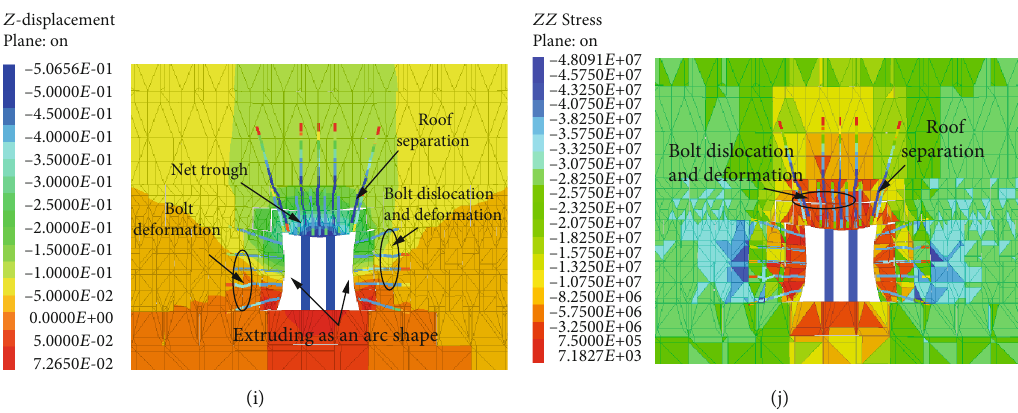
Figure 11: Numerical simulation results of surrounding rock deformation in the di ff erent schemes: (a) cloud graph of vertical displacement of scheme 1; (b) cloud graph of vertical stress of scheme 1; (c) cloud graph of vertical displacement of scheme 2; (d) cloud graph of vertical stress of scheme 2; (e) cloud graph of vertical displacement of scheme 3; (f) cloud graph of vertical stress of scheme 3; (g) cloud graph of vertical displacement of scheme 4; (h) cloud graph of vertical stress of scheme 4; (i) cloud graph of vertical displacement of scheme 5; (j) cloud graph of vertical stress of scheme 5. Table 4: Roadway deformation in the di ff erent